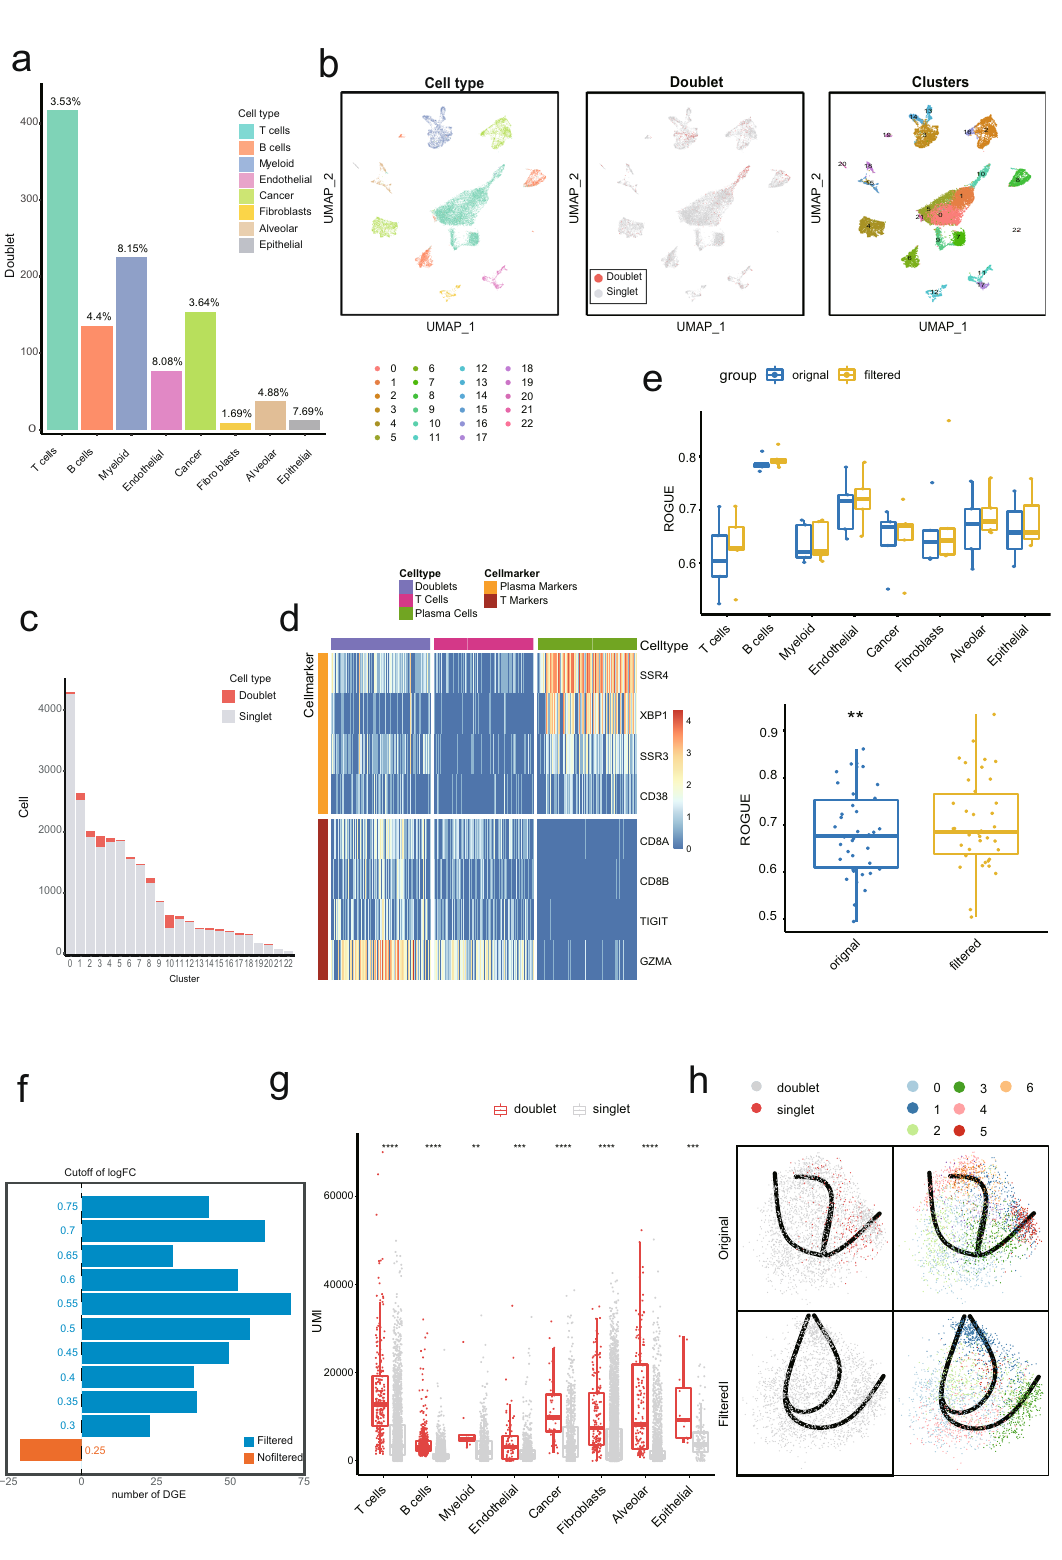
the R package monocle and Slingshot software were used for a pseudotime analysis of the dataset. We implemented the process described above for each method. In addition, we calculated the trajectories of the clean and contaminated datasets. Time cost . Based on random sampling from the real DM-2.1 dataset, we con- structed test datasets of 1,000 to 12,000 cells with a gradient of 1,000 cells and tested various methods with the same processor. Then, the runtime of each method